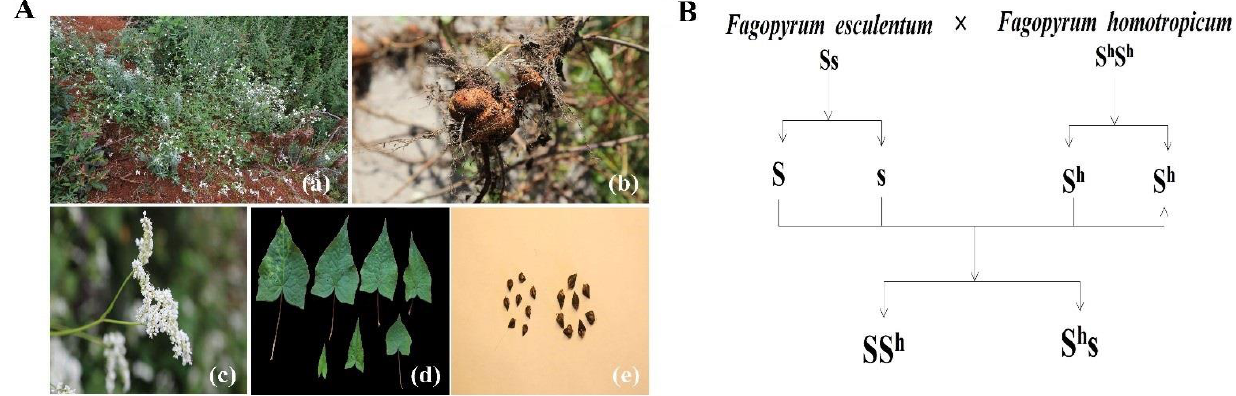
Figure 5. The utilization of F. cymosum and F. homotropicum . ( A ) represents the morphological characteristics of F. cymosum . ( B ) represents a flowchart of the wide hybridization between F. homotropicum and F. esculentum